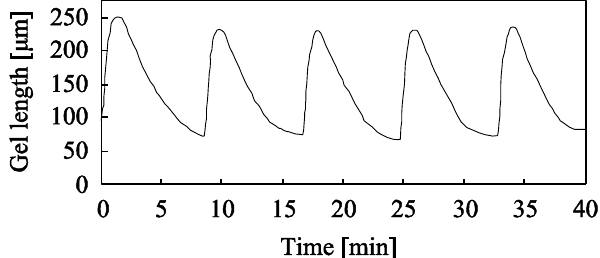
Figure 5. Oscillating profile of cubic gel. Cubic gel (each side length is about 0.5 mm) was immersed in 1 mL of the mixture solution of the BZ substrates (62.5 mM malonic acid, 84 mM sodium bromate, 0.894 M nitric acid, 18 °C). S. Maeda et al. Peristaltic motion of polymer gels. Angew. Chem. Int. Ed. 2008 , 47 , 6690-6693. Copyright Wiley-VCH Verlag